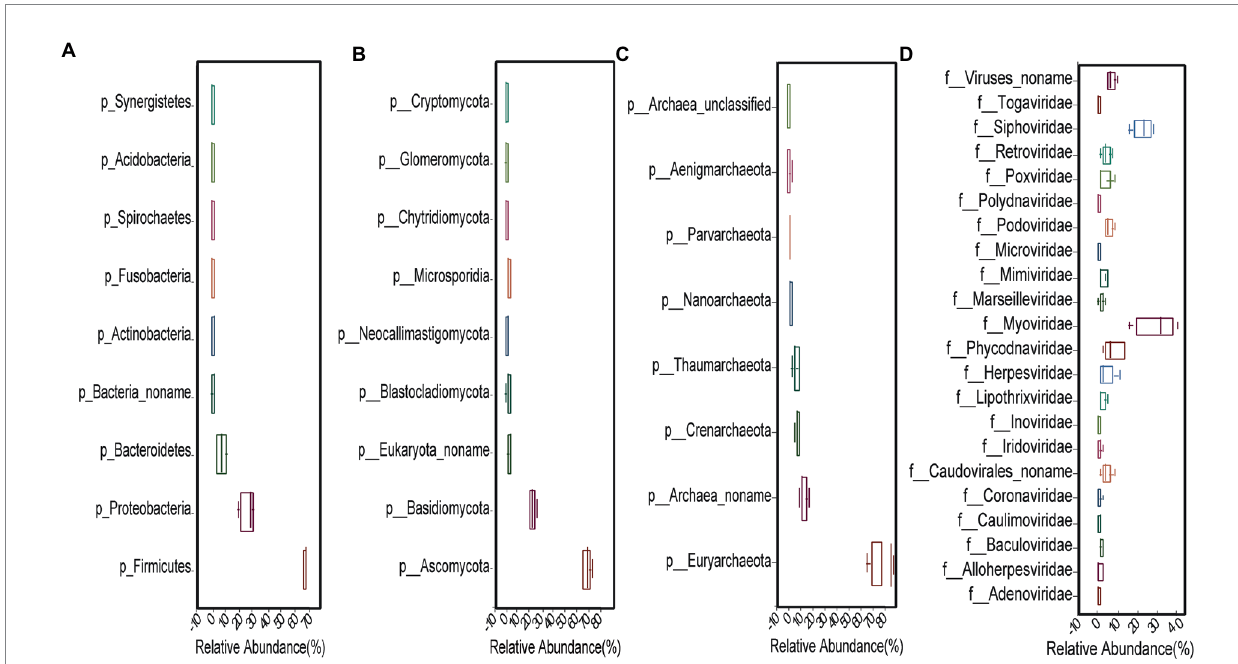
FIGURE 2 Relative abundances of (A) bacteria, (B) fungi, and (C) archaea at phyla level and (D) viruses at family level.